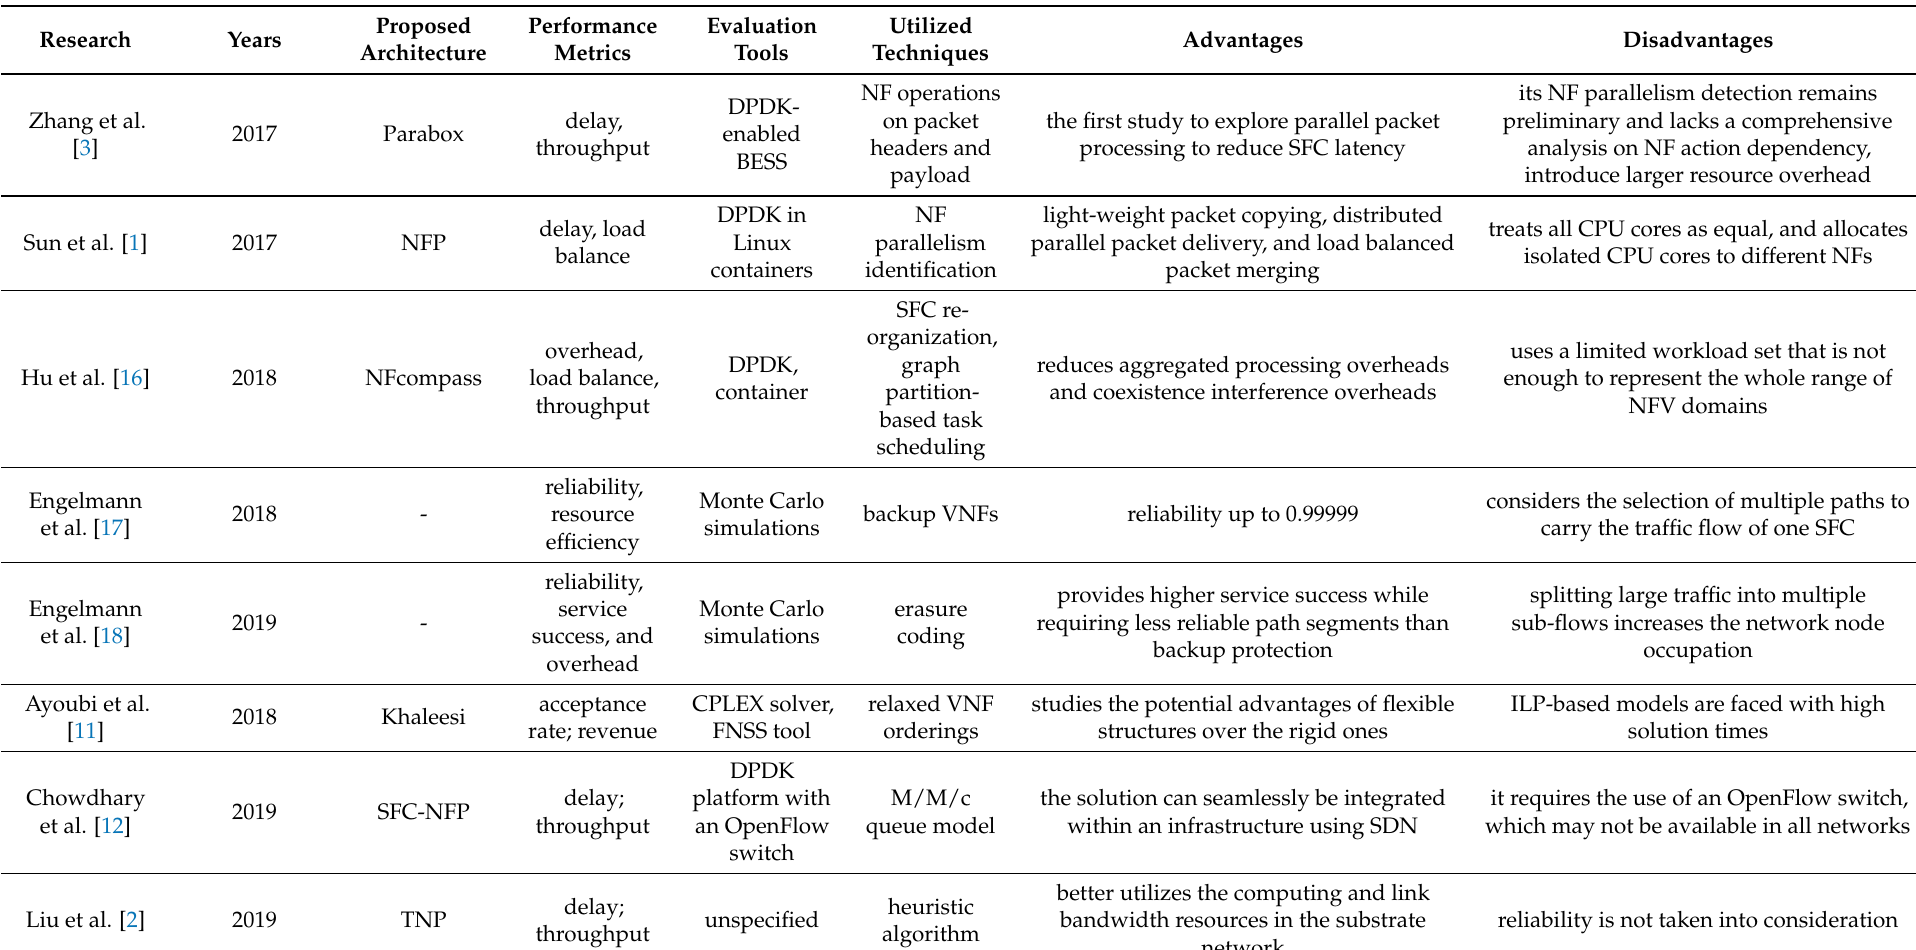
Table 1. A systematic review of parallelized SFC architecture and